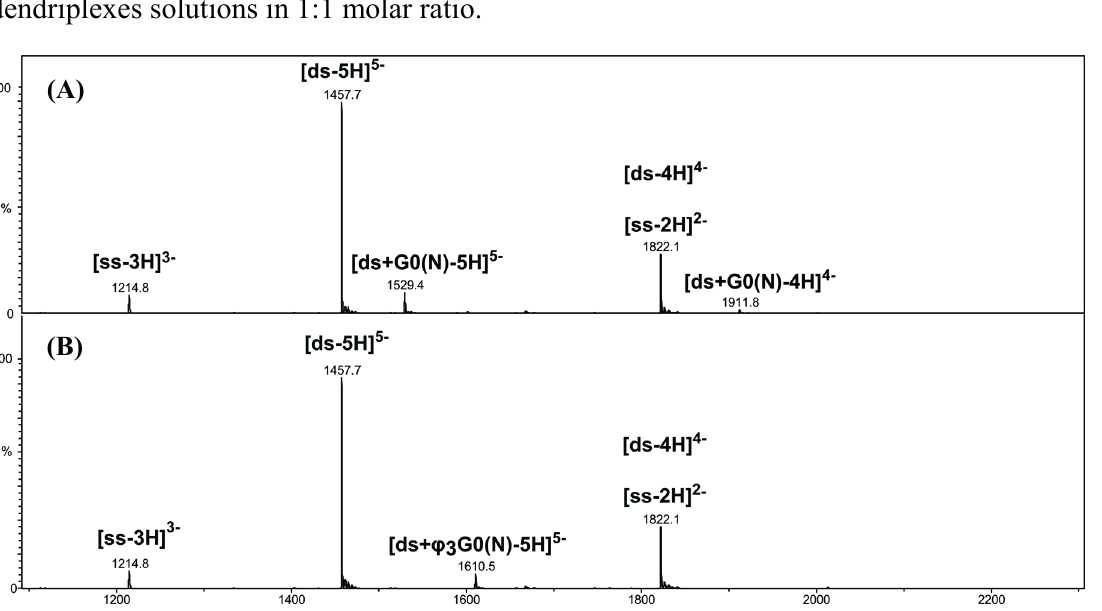
Figure 3. Negative-ion ESI mass spectra of [ ds /G0(N)] ( A ) and [ ds / φ 3 G0(N)] ( B ) dendriplexes solutions in 1:1 molar